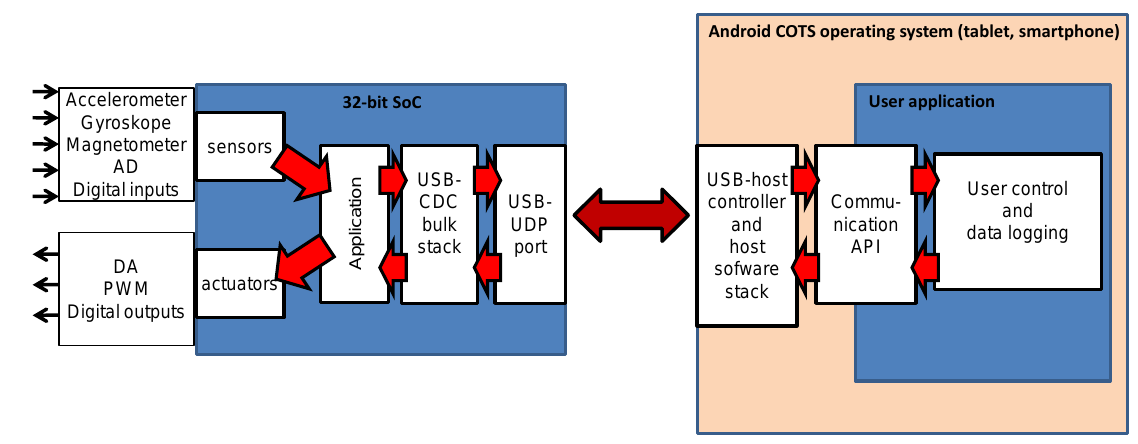
Figure 2. Software architecture of system’s key